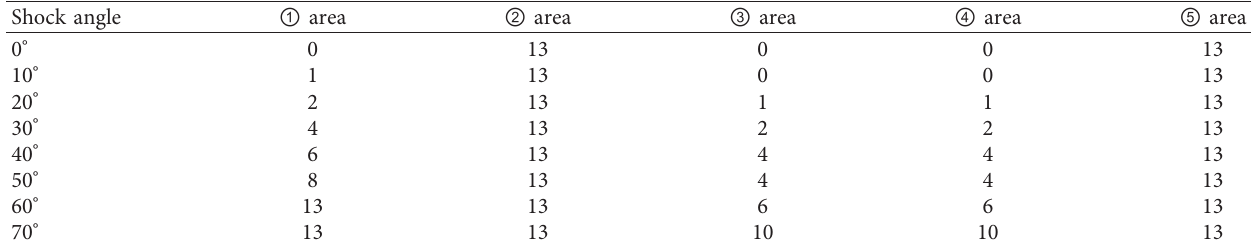
Table 1: Length of the mortise with which laser beam did not interfere (mm).